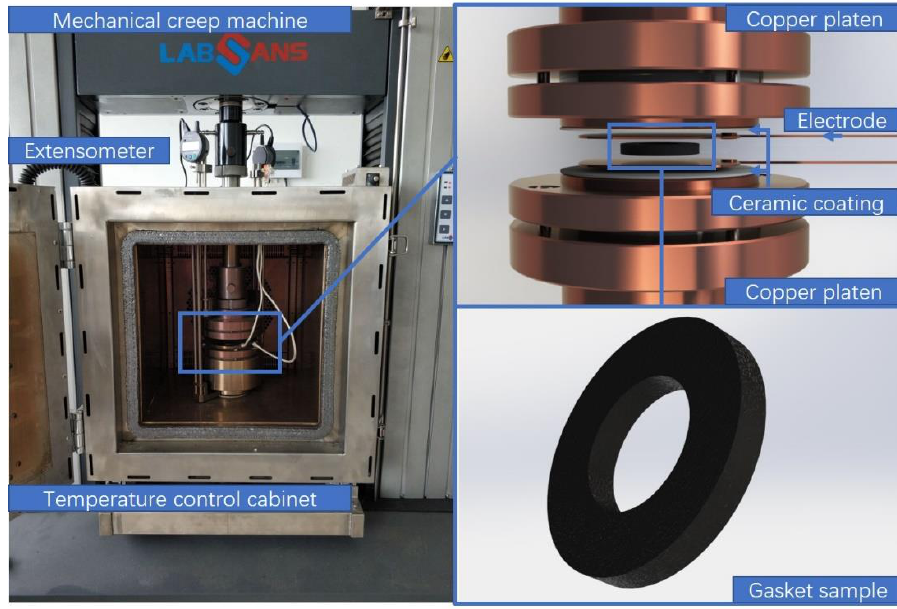
Figure 1. Photo of the mechanical creep test machine equipped with a temperature control cabinet and resistivity measurement. Insulation coating treatment was performed on the contact surfaces of the compressive indenters.